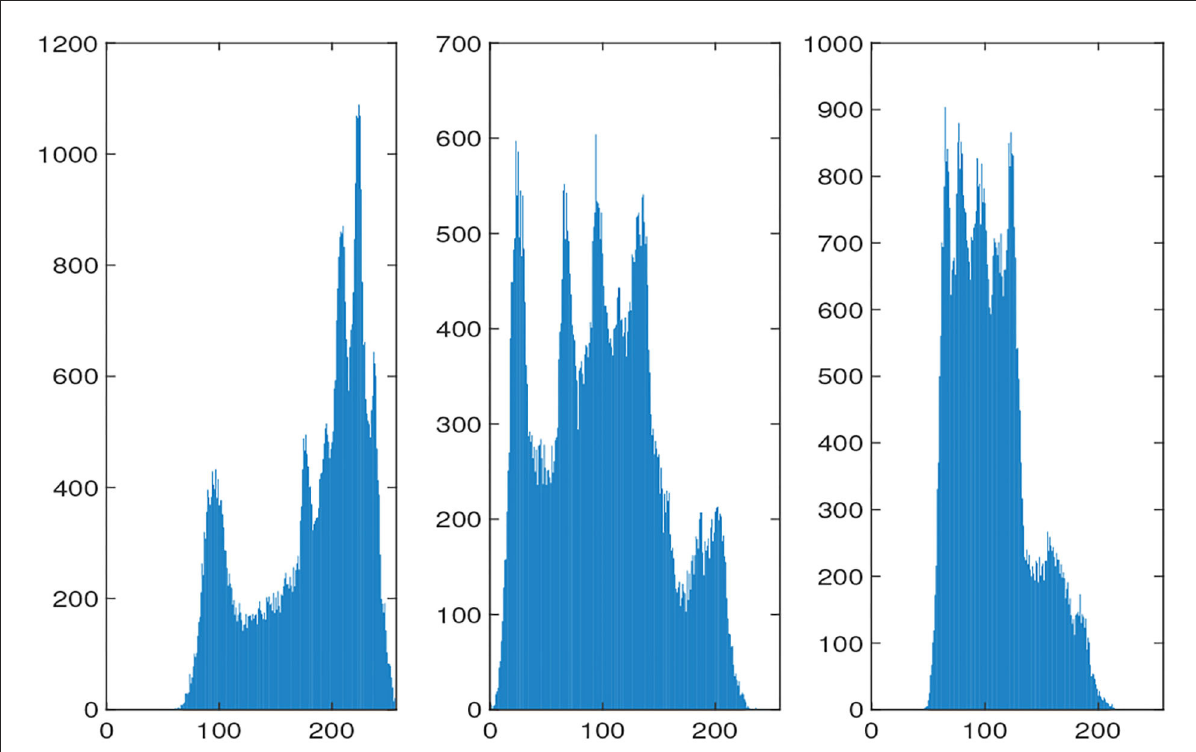
FIGURE11 Histograms of RGB for the original picture.